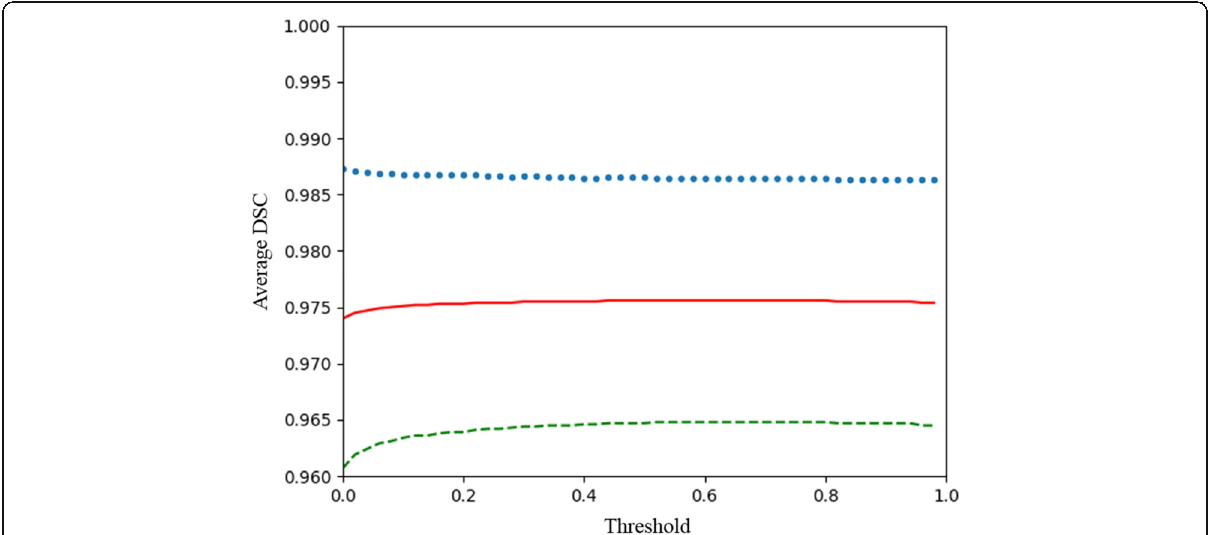
Fig. 4 Mean dice similarity coefficient of the proposed method with binarization of different threshold values. The red line denotes the mean DSCs of all deep learning network outputs after binarization of different threshold values; the dashed green line and the dotted blue line denote one standard deviation below and above the mean DSC, respectively. DSC: Dice similarity